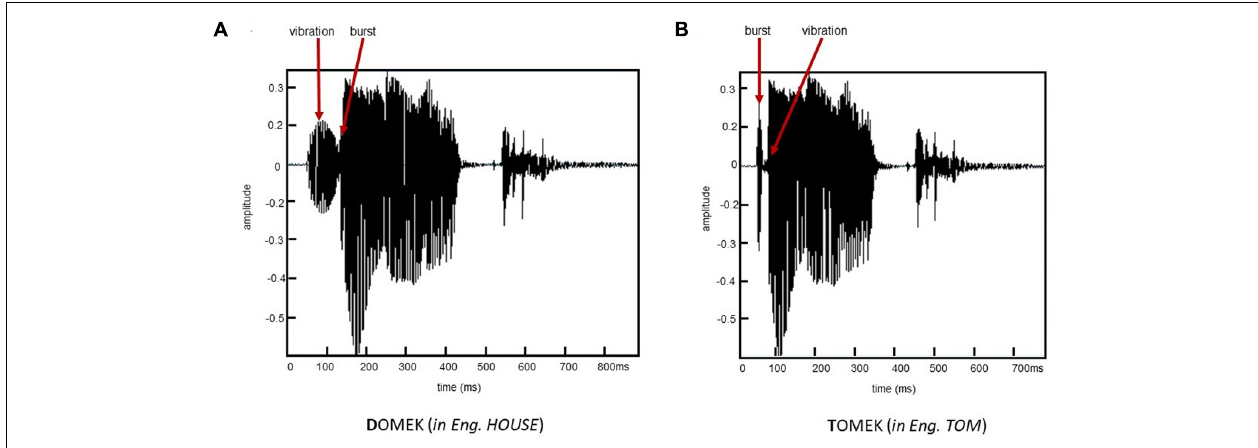
FIGURE 1 | Waveforms of two words from the endpoints of applied VOT spectrum: (A) VOT of –90 ms identified as D OMEK and (B) Voice-onset-time (VOT) of 20 ms identified as T OMEK.